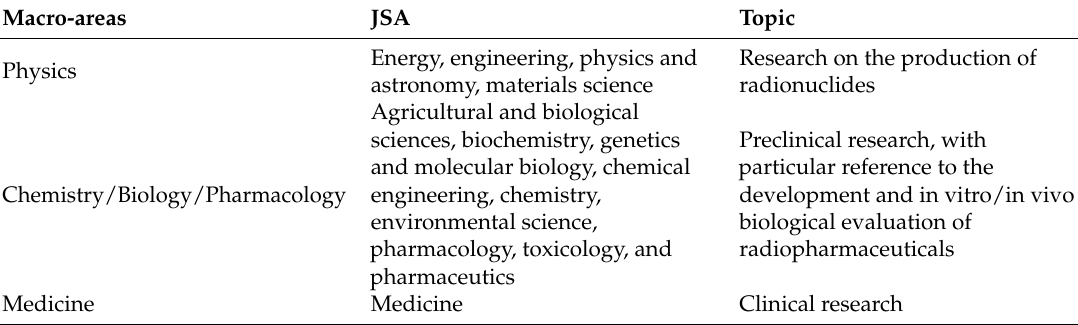
Table 11. Classification of Journal Subject Areas (JSAs) into